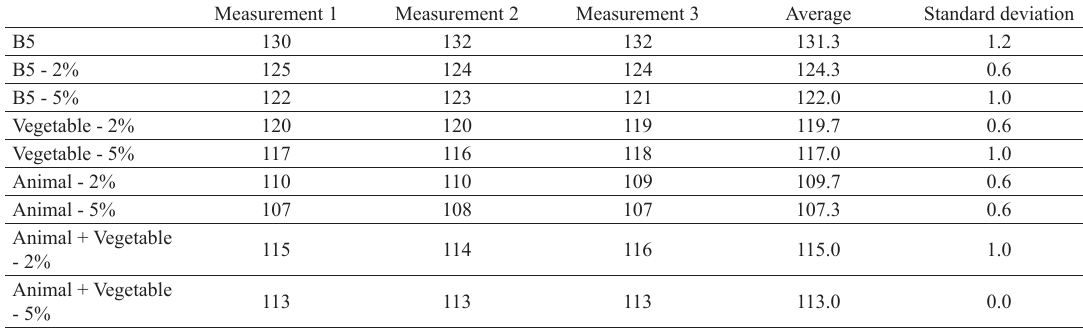
Table 5. PQA values after all tests.